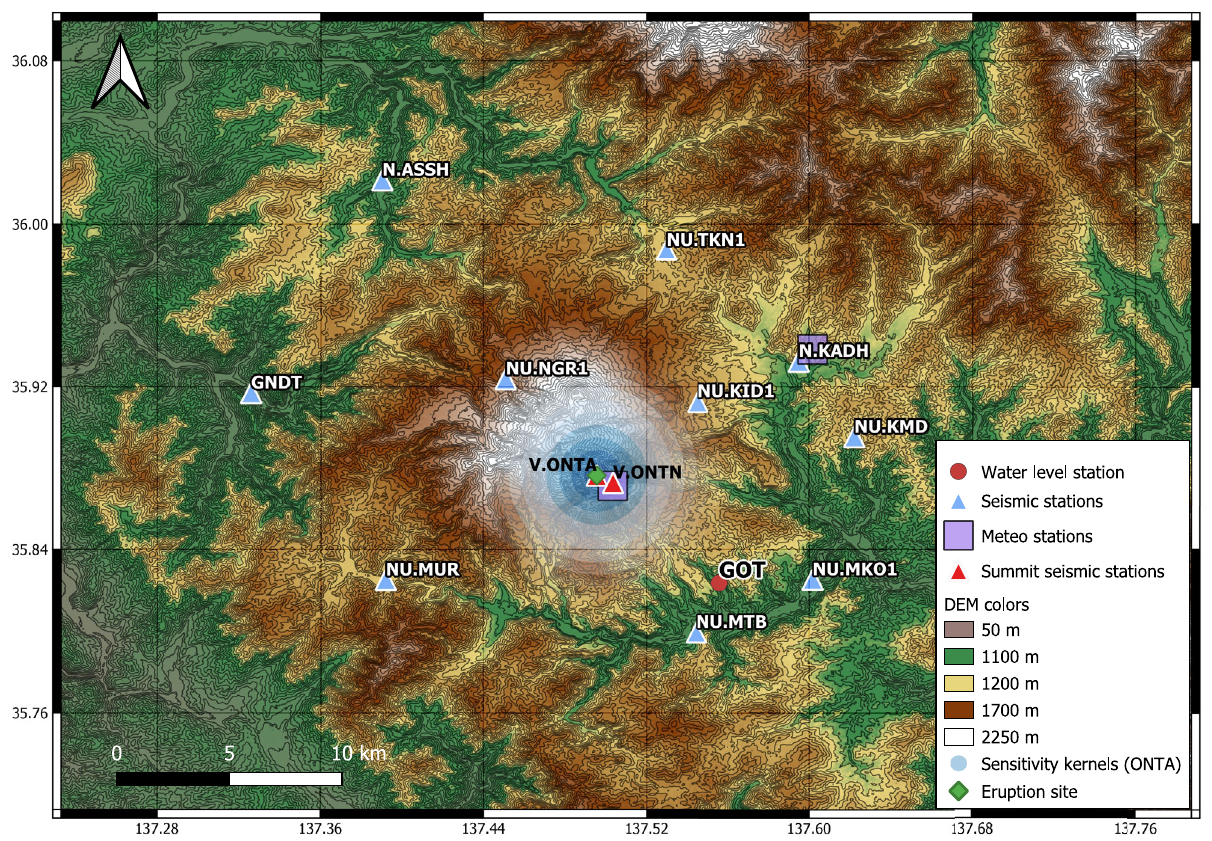
Fig.1|MapofMtOntakenetwork. Seismicstationlocations(triangles).MKOand TKNare broadband seismometers(naturalperiod of 120s), whereastheothersare short-period sensors (natural period of 1s). The locations of the meteorological stations (purple transparent squares co-located with seismic stations N.KADH and V.ONTN) and the groundwater station (red circle; the reference water level is 645